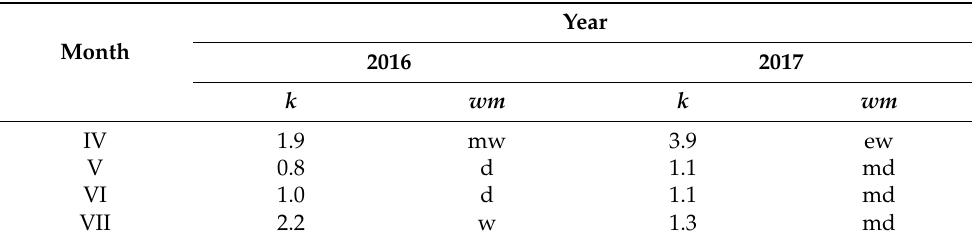
Table 3. Values of the Selyaninov hydrothermal index (k) during the vegetation periods of triticale and moisture characteristics (wm) of individual